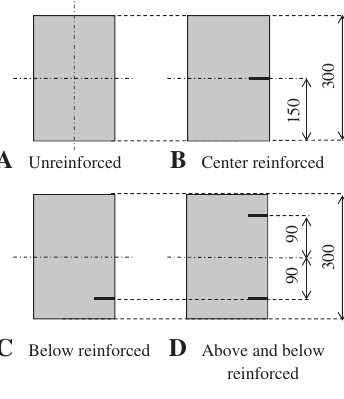
Figure 1 Cross section of specimens (unit: mm).